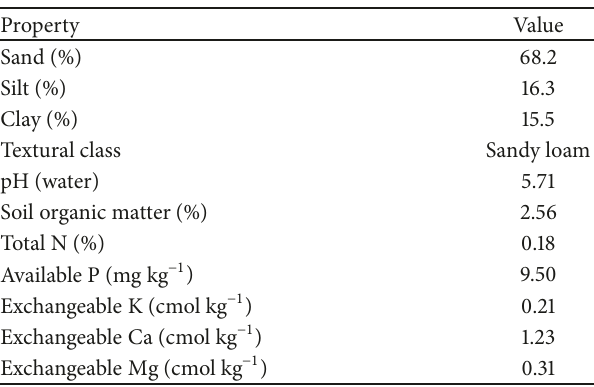
Table 1: Initial soil characteristics before